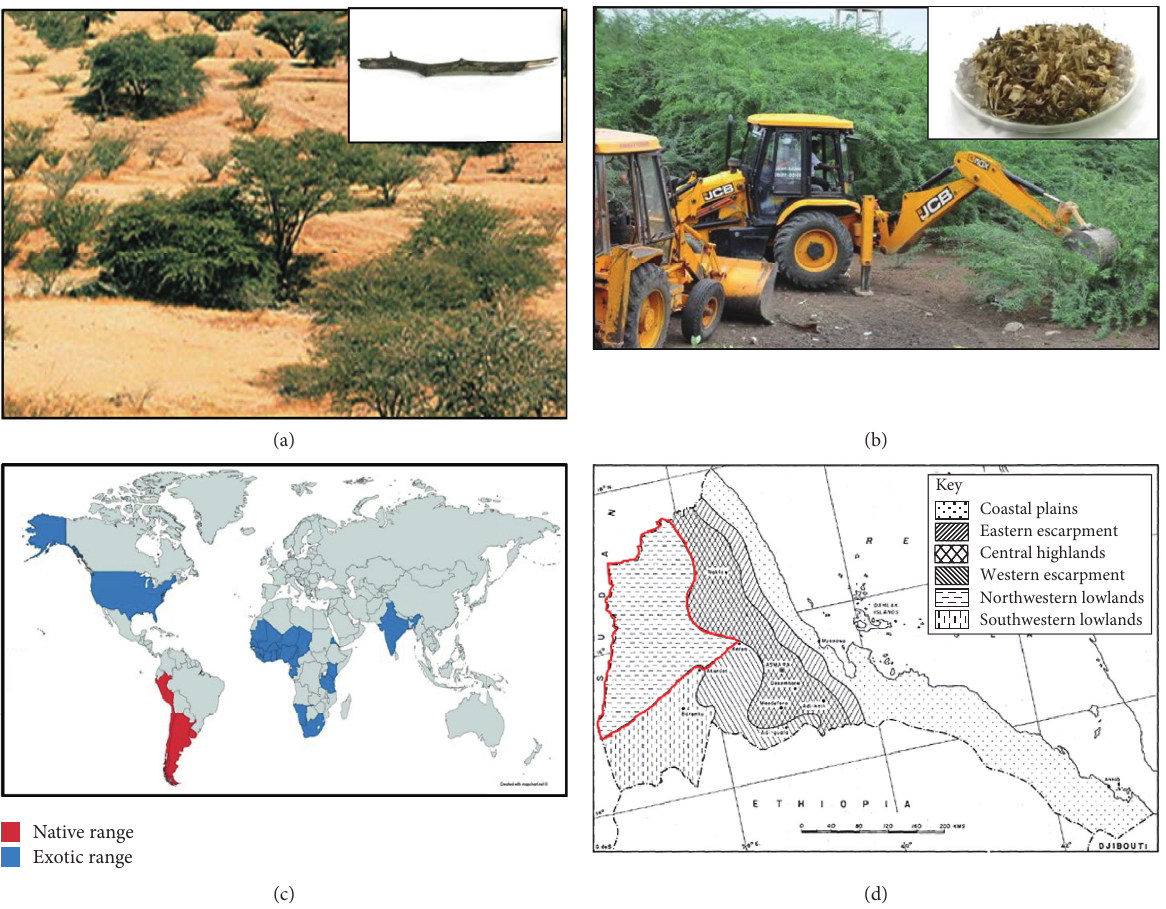
Figure 1: Picture of (a) temer musa tree, (b) uprooting process, (c) the map of countries where the species are available, and (d) the main agroclimatic zone of Eritrea where the trees are most available (highlighted in red border) [21]. The wood branch of temer musa is shown in the inset of (a), and small pieces of original temer musa are shown in the inset of (b).